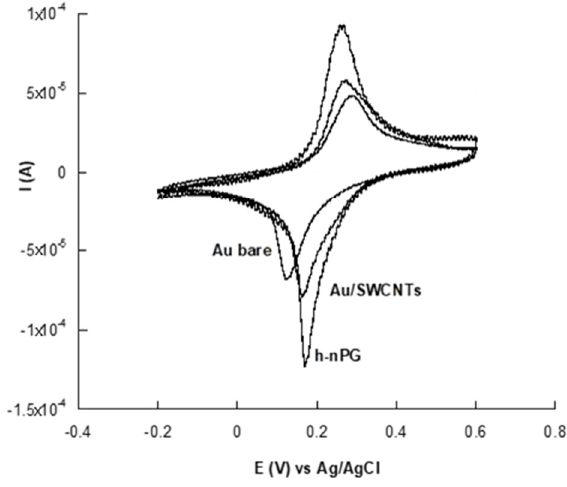
Figure 3. CVs for Au bare (solid line), Au/SWCNTs (dashed line) and h-nPG (dotted line) gold electrodes in 5 mM [Fe(CN) 6 ] 3 − /4 − and 0.1 M KCl, υ = 100 mV s − 1 .